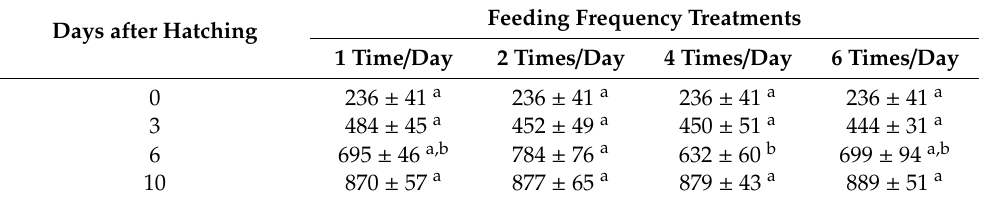
Table 6. Mouth opening gape ( µ m) of P. hypophthalmus larvae at four developmental time points following subjection to different feeding frequency treatments.